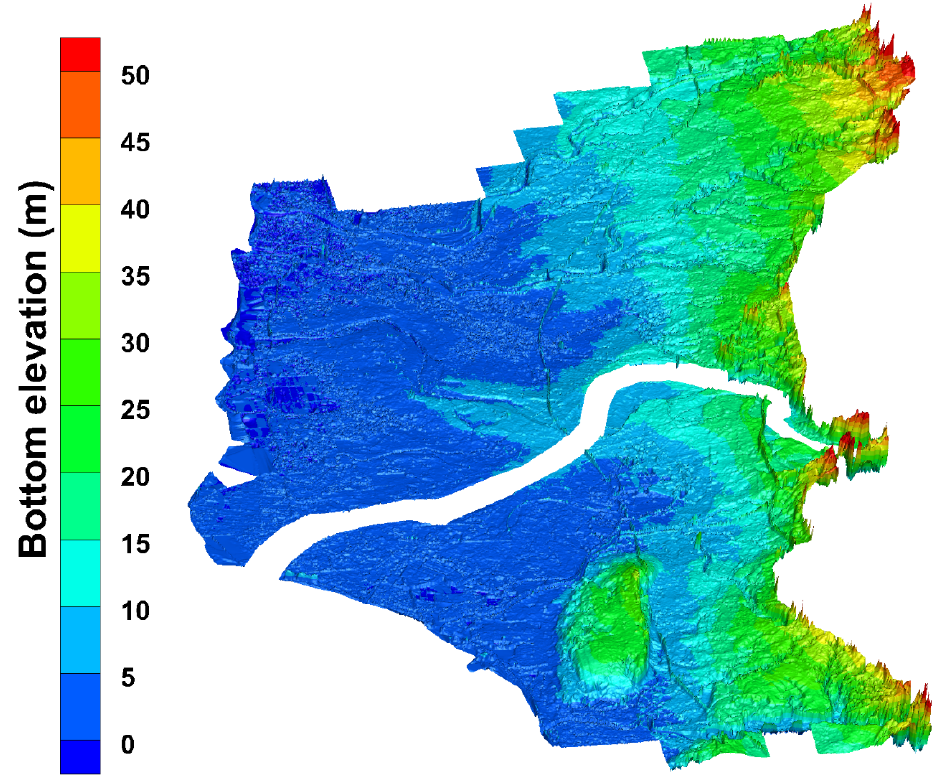
Figure 6. Three-dimensional view of bottom elevation for the computational domain using a digital elevation model (DEM) with a spatial resolution of 1 m.